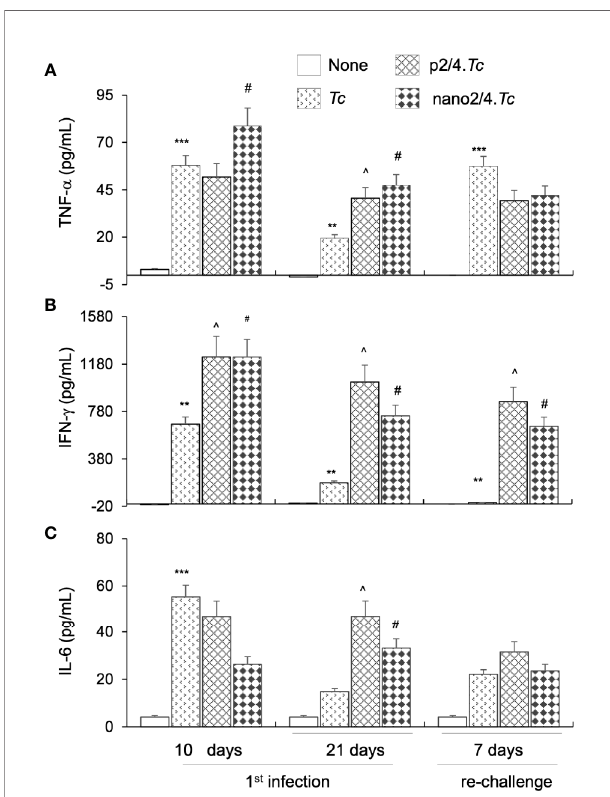
FIGURE 6 | Systemic markers of in fl ammation in mice after acute infection and re-challenge with T. cruzi (± nanovaccine). Mice were immunized and infected and re-challenged as described in Figures 1A and 4A . Serum samples were obtained at day 10 and 21 post-infection and day 7 after re- challenge, and TNF- a (A) , IFN-g (B) , and IL-6 (C) levels were evaluated by using commercially available ELISA kits. Data (mean ± SEM) are representative of triplicate observations per sample ( n ≥ 5 mice per group). Signi fi cance was calculated by student ’ s t-test (* no infection vs. Tc ) and one- way ANOVA/Tukey ’ s ( ^ Tc vs. p2/4. Tc and # Tc vs. nano2/4 .Tc ). One, two, and three symbol characters were used to annotate the p values of <0.05, <0.01, and <0.001,